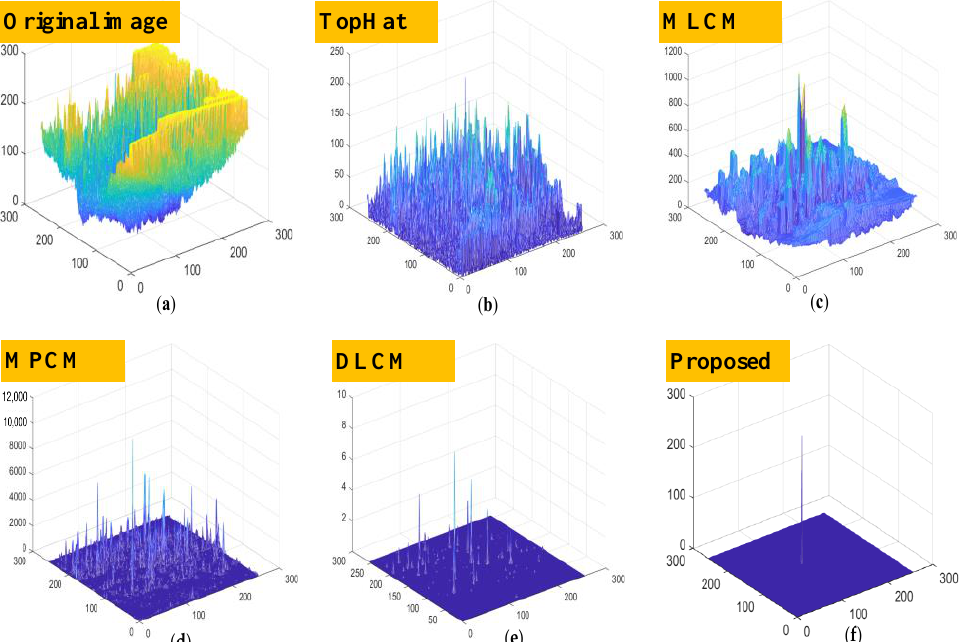
Figure 6. Three-dimensional chart of detection result. (a) 3-D image of original image. (b) 3-D image of result of Top-Hat. (c) 3-D image of result of MLCM. (d) 3-D image of result of MPCM. (e) 3-D image of result of DLCM. (f) 3-D image of result of Proposed. Table 2. BSF and SCRG of different algorithms.